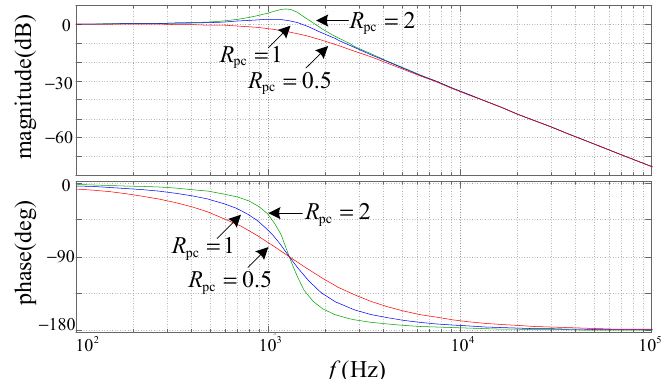
R , the damping effect was enhanced. How- pc